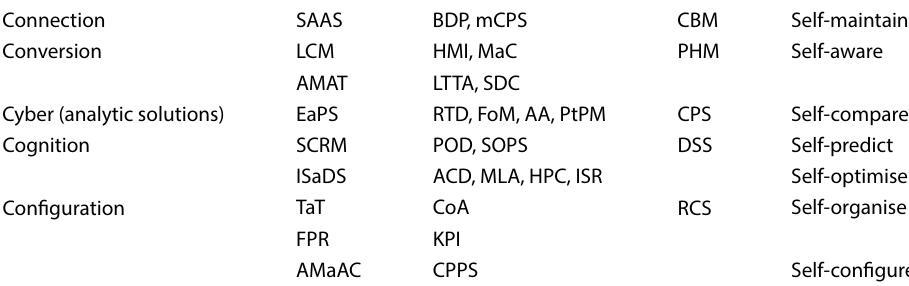
Table 3 The applications and technologies related to artificial intelligence for CPS